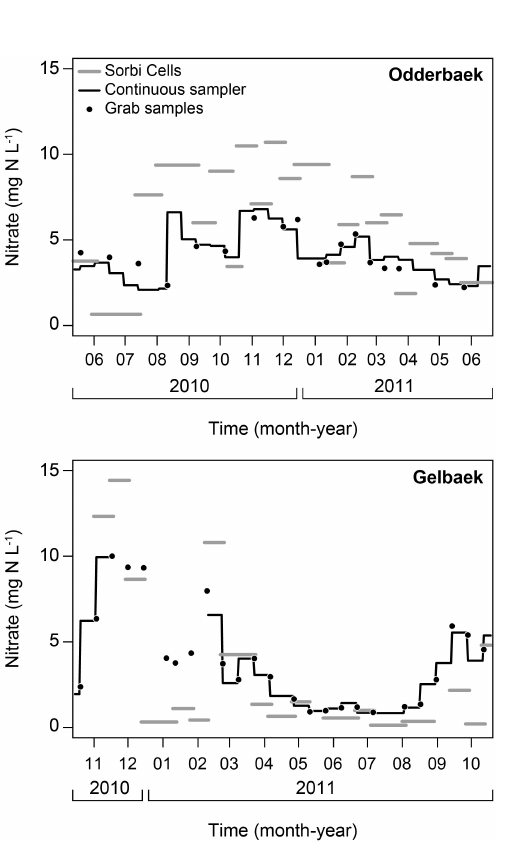
Figure 3. Nitrate concentrations at Odderbaek and Gelbaek deter- mined by passive samplers, grab sampling and time-proportional sampler. The monitoring by the time-proportional sampler at Gel- baek was interrupted in winter because of